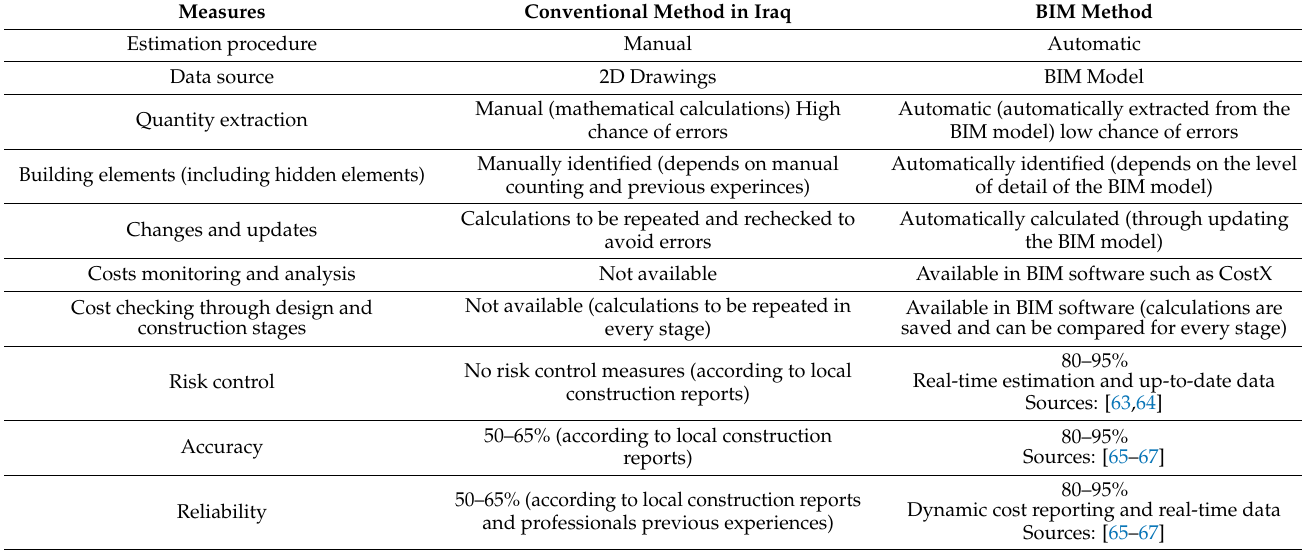
Table 3. Construction costs estimation: Conventional method vs. BIM